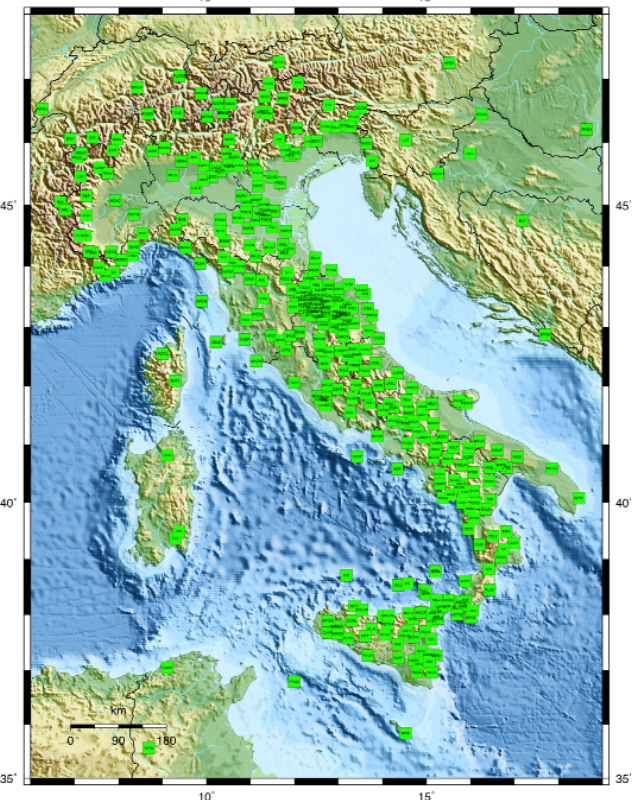
Figure 2. Map of the extended national network on which the seismic sur- vey of Italy is founded. The stations are contributed by national and in- ternational institutes, and are mostly equipped with high-resolution broadband